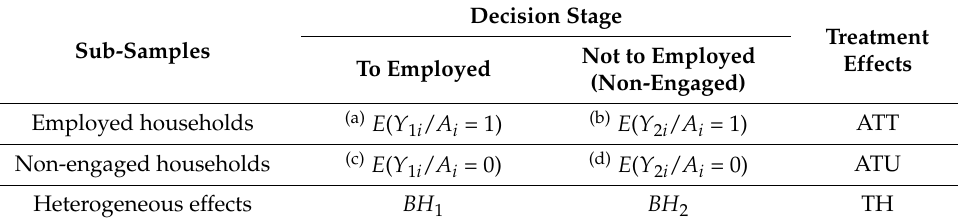
Table 5. Conditional expectations, treatment, and heterogeneous effect. Decision Stage Treatment Sub-Samples EffectsTo Employed Not to Employed (Non-Engaged) Employed households